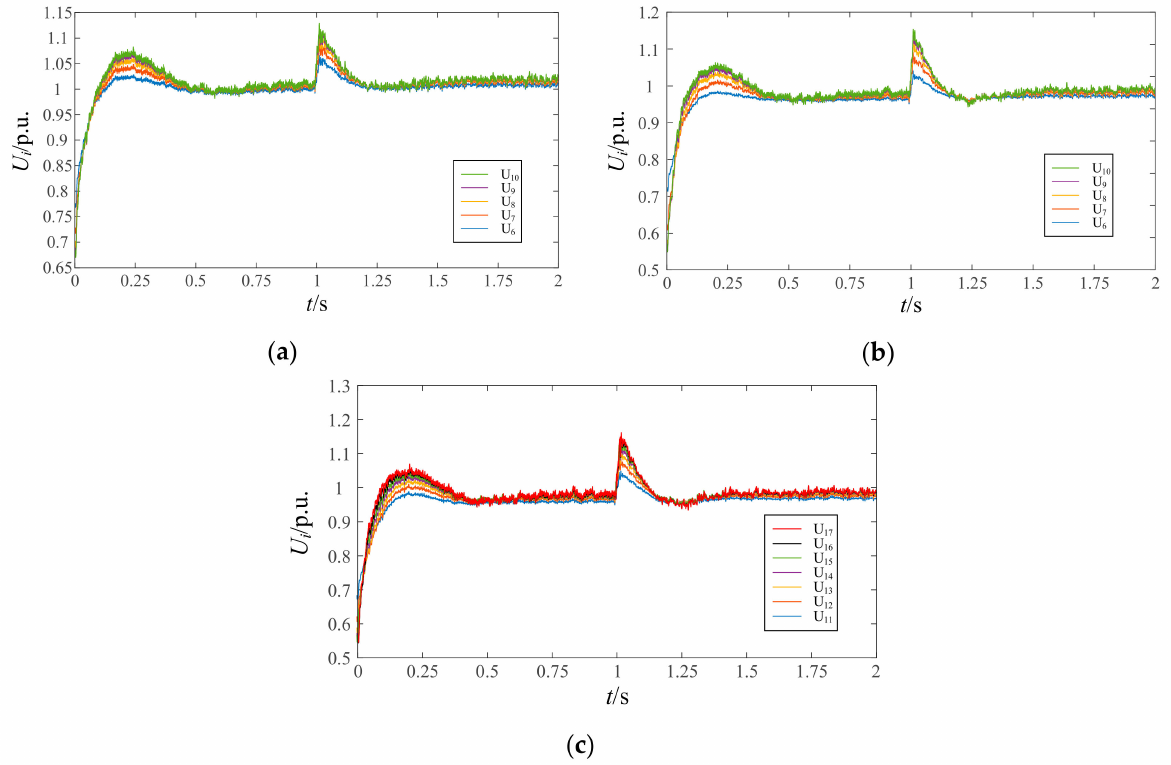
Figure 16. The generator terminal voltage variation curves, adopting the proposed strategy. ( a ) Line 1. ( b ) Line 2. ( c ) Line 3.